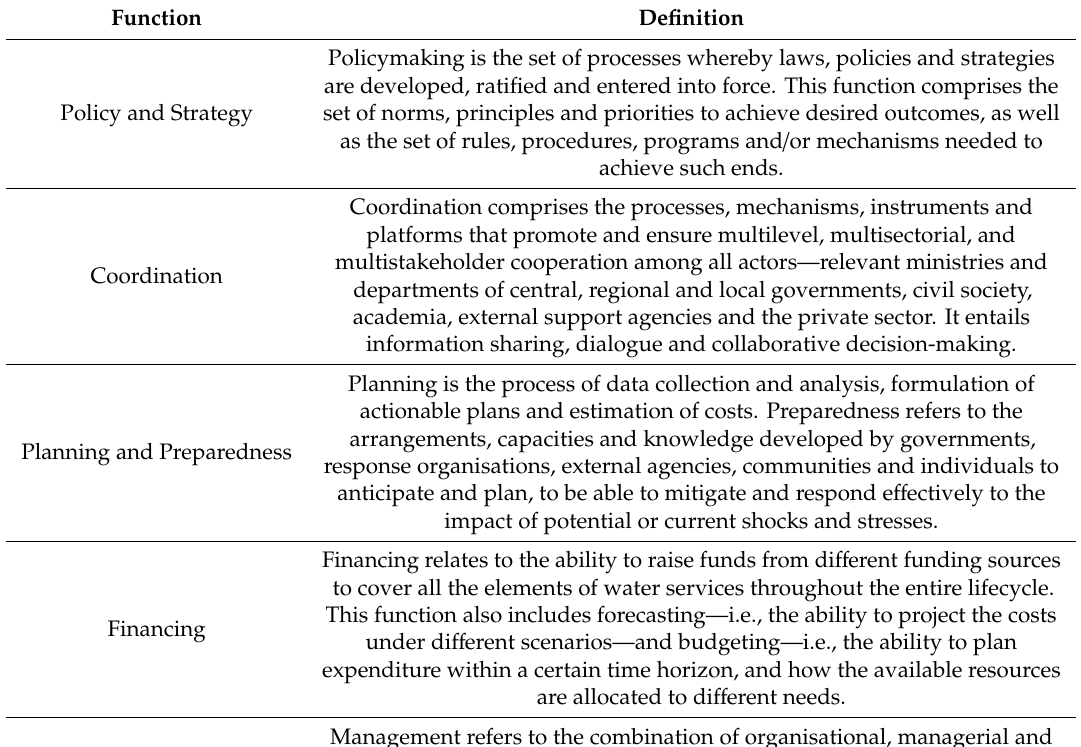
Table 2. Summary of core water governance functions